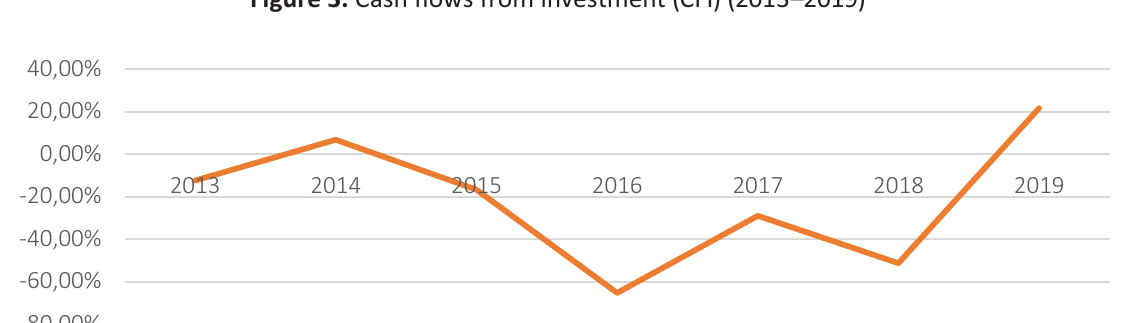
Figure 3. Cash flows from investment (CFI) (2013–2019)